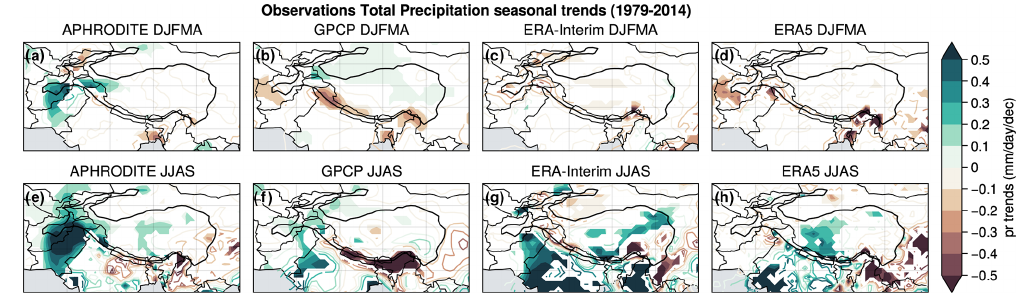
Figure D3. Same as Fig. 7 but for observations and reanalyses comparison with only total precipitation.